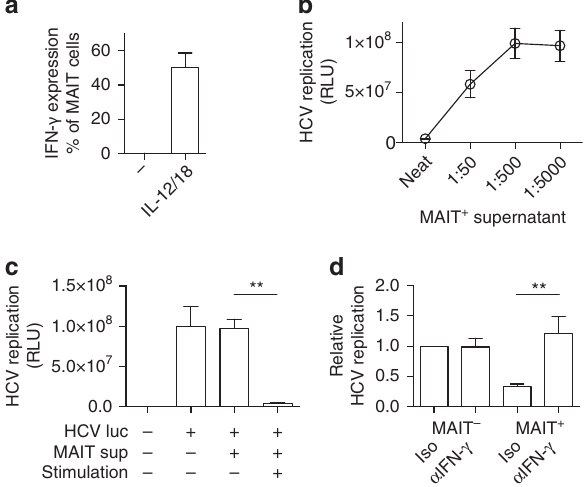
– Figure 7 | Activated MAIT cells can limit HCV replication. Sorted MAIT cells (CD8 þ CD161 þ þ V a 7.2 þ ) were rested or activated in a TCR- independent manner (IL-12 þ IL-18 stimulation, MAIT þ ) for 24h. ( a ) IFN- g expression by MAIT cells (gated on live CD3 þ CD8 þ CD161 þ þ V a 7.2 þ cells) was analysed by flow cytometry. ( b , c ) Neat or diluted supernatants were transferred to hepatocyte lines infected with HCV expressing luciferase and viral replication measured 4 days post infection. ( d ) Supernatants were transferred to hepatocyte lines infected with HCV expressing luciferase repeated in the presence of an isotype control or anti-IFN- g antibody. Data are representative from at least two independent experiments. Bars represent means ± s.e.m. Statistical significance was determined with a Wilcoxon matched-paired test ( c ) or the Mann–Whitney test ( d ). ** P r 0.01. (cid:2) , unstimulated; luc, luciferase; RLU, relative light units; sup, supernatant. supernatants of unstimulated and stimulated MAIT cells were transferred to a hepatocyte line infected with HCV expressing luciferase, allowing measurement of HCV replication. The activated MAIT cell supernatants were able to potently suppress HCV replication, while no activity from control supernatants (Fig. 7b) or from IL-12 and IL-18 (data not shown) addition to hepatocytes was seen. Diluting the activated MAIT cell supernatant reduced the suppression of HCV replication in a dose-dependent manner (Fig. 7c). Addition of anti-IFN- g reversed the HCV suppression by activated MAIT cell supernatants (Fig. 7d). In an extension of the experimental set up using virally-induced activation to trigger MAIT cells, supernatants from MAIT cells incubated with HCV-treated macrophages reduced HCV replication in the hepatocyte reporter cell line compared to mock-treated macrophages (Supplementary Fig. 10). These results indicate that activation of MAIT cells by viral triggers induces responses that can impact on viral replica- tion in vitro. MAIT cells are an abundant human T-cell population with a semi-invariant TCR determining bacterial specificity. It has previously been considered that MAIT cells were not responsive to viral infection 37 . However, in this study we provide data to show MAIT cells are also readily and specifically activated by pathogenic viruses in vivo and in vitro . Furthermore, we define mechanisms that allow this virally-driven activation, and show they are distinct in the different viral settings. The in vivo data shows that there is evidence of MAIT cell activation in response to DENV, HCV and influenza virus.